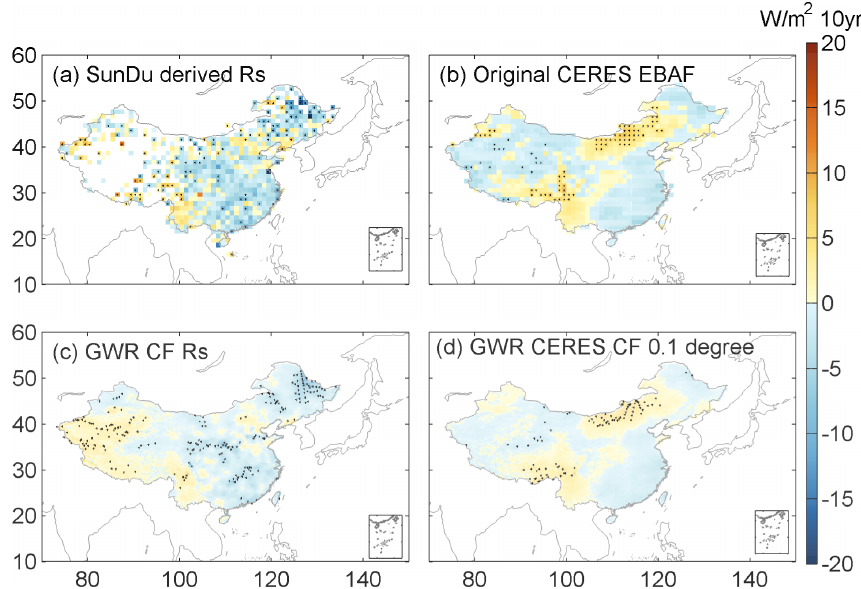
Figure 9. Spatial distributions of monthly anomaly trends of surface solar radiation ( R s ) from 2000 to 2017. The first line (a, b) shows the SunDu-derived R s and CERES EBAF R s ; the R s -derived GWR fusion methods are shown in the second line (c, d) . (c) SunDu-derived R s incorporates only CF, and (d) is the results of GWR analysis using CERES data interpolated to 0.1 ◦ and 0.1 ◦ cloud. The black dots on the maps represent significant trends ( P < 0 . 05).